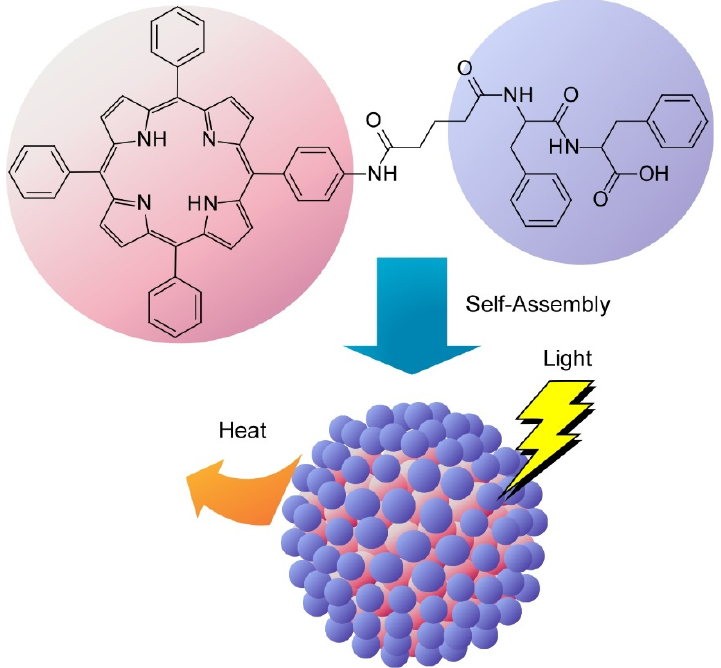
Figure 24. Photothermal nanodots from peptide-porphyrin conjugates for photothermal antitumor